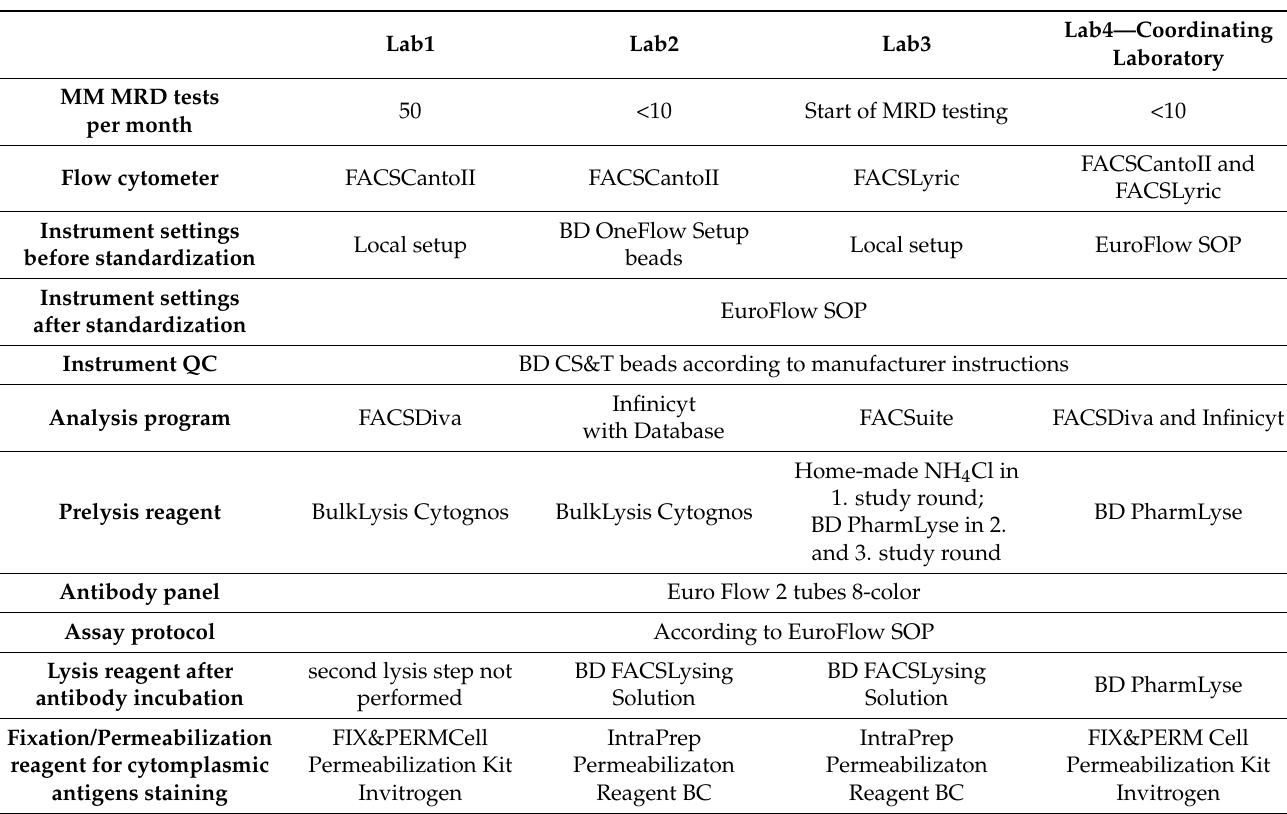
Table 1. Results of a preliminary survey and MM MRD assay conditions used in the inter-laboratory